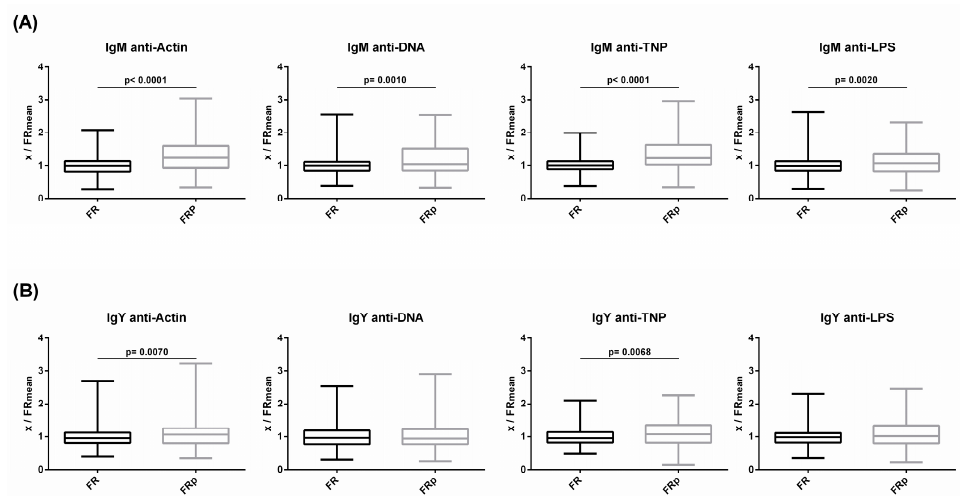
Figure 6. Comparison of NAb levels of slow ‐ growth broilers between those fed a normal diet and those fed a diet supplemented with plant extracts: ( A ) IgM and ( B ) IgY NAb levels were estimated by binding capacity of serum NAbs to actin, DNA, TNP and LPS. On the y axis, values are given as a ratio of individual NAb levels relative to the mean NAb levels of the control group [y = OD(x)/meanOD(FR)].